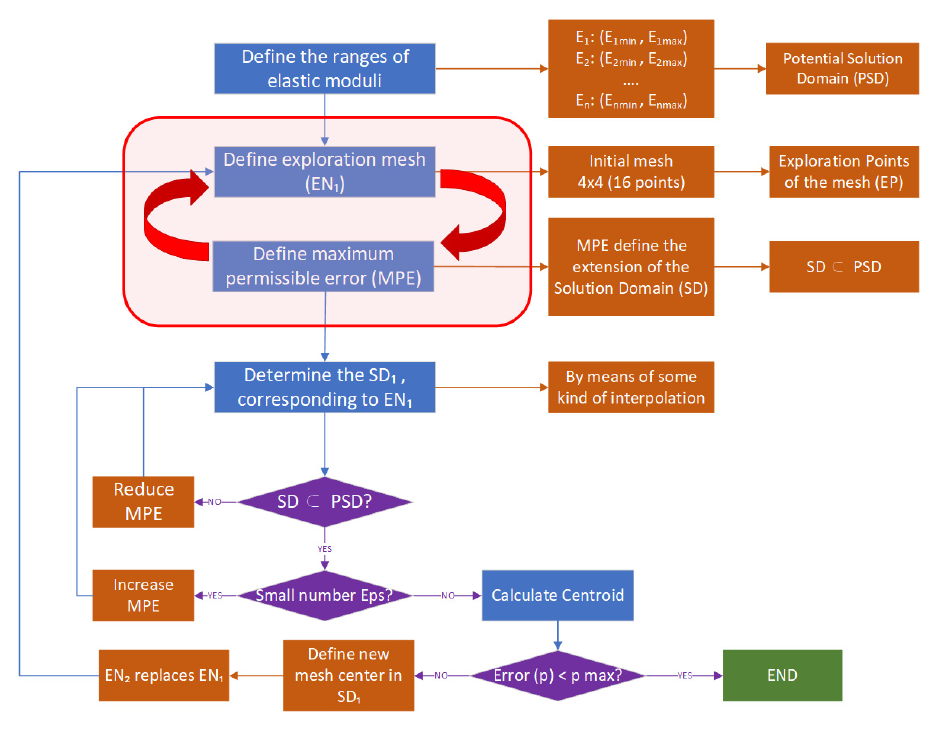
Figure 8. The centroid